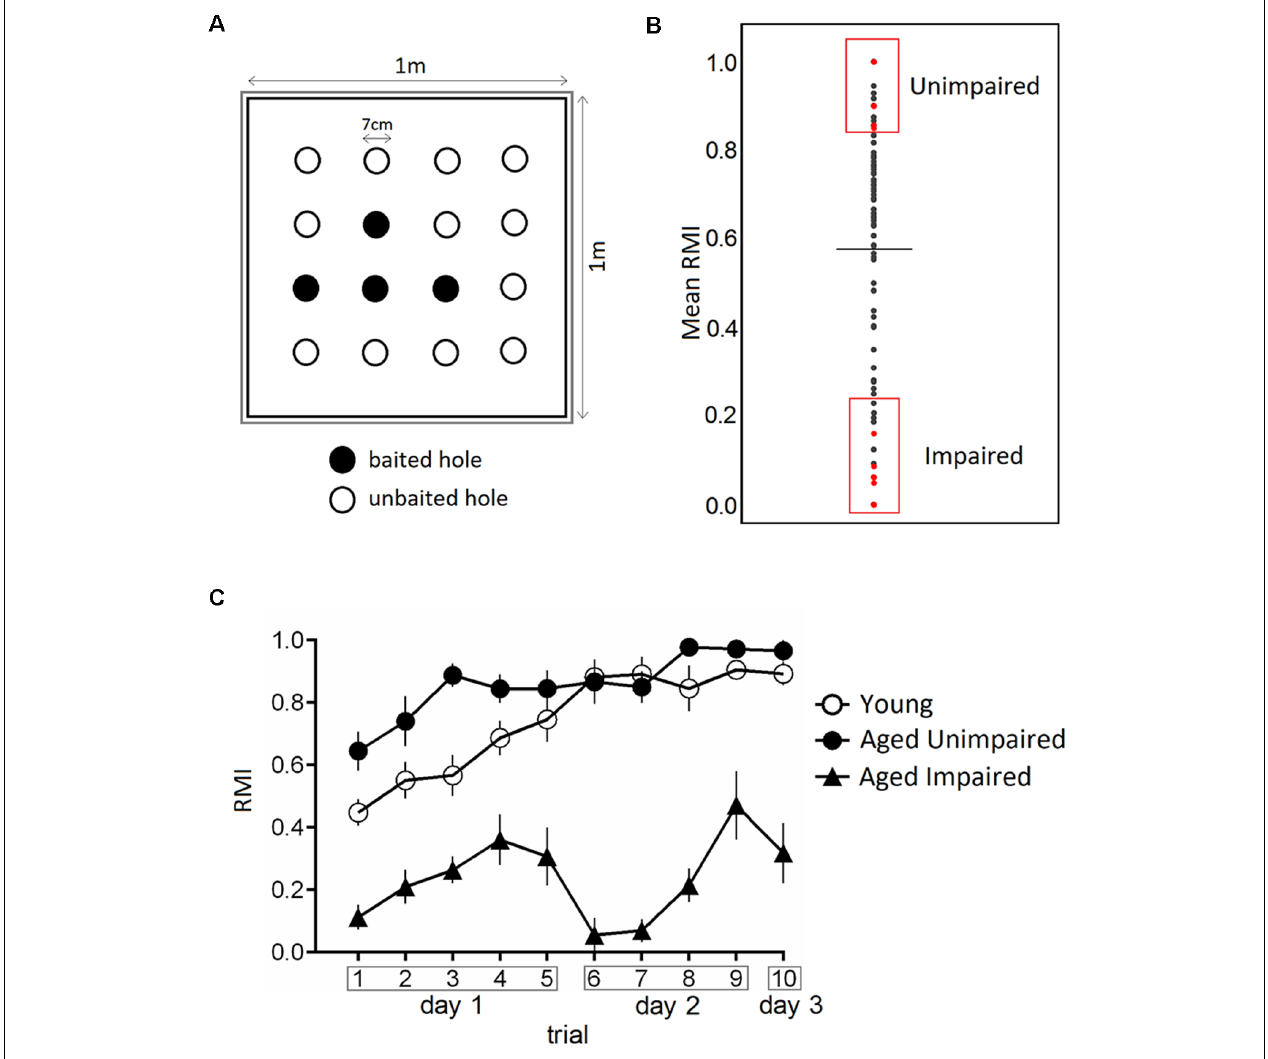
FIGURE 1 | Performance in the hole-board test. (A) Schematic of the hole-board maze, a non-sophisticated paradigm for the evaluation of spatial memory. Animals have to learn and remember position of four baited holes during 3 days in 10 trials. (B) From a large cohort of 160 male Sprague–Dawley rats, 22–24 months old, impaired and unimpaired performers were selected based on their mean Reference Memory Index (RMI) derived from trial 6 and 10 ± 1 standard deviation (SD). The dashed line indicates the mean of mean RMIs. (C) Performance of young, aged impaired (AI) and aged unimpaired (AU) rats in the hole-board test. The data are presented as mean ± SEM, n = 9. AU animals performed the task comparable to young